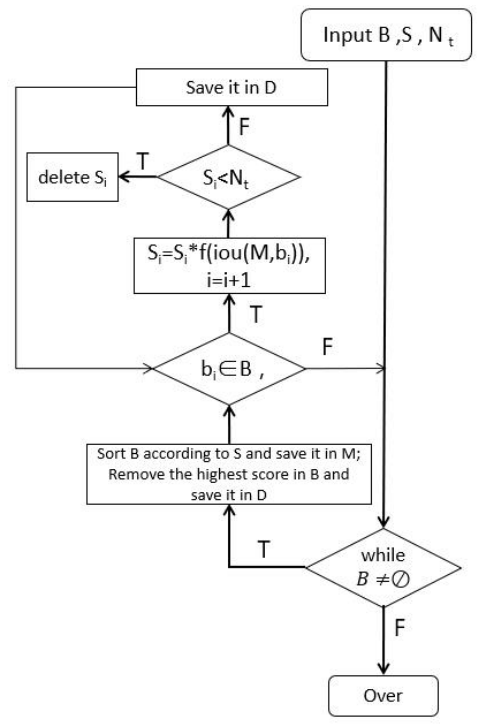
Figure 3 . Flow chart of soft-NMS algorithm.